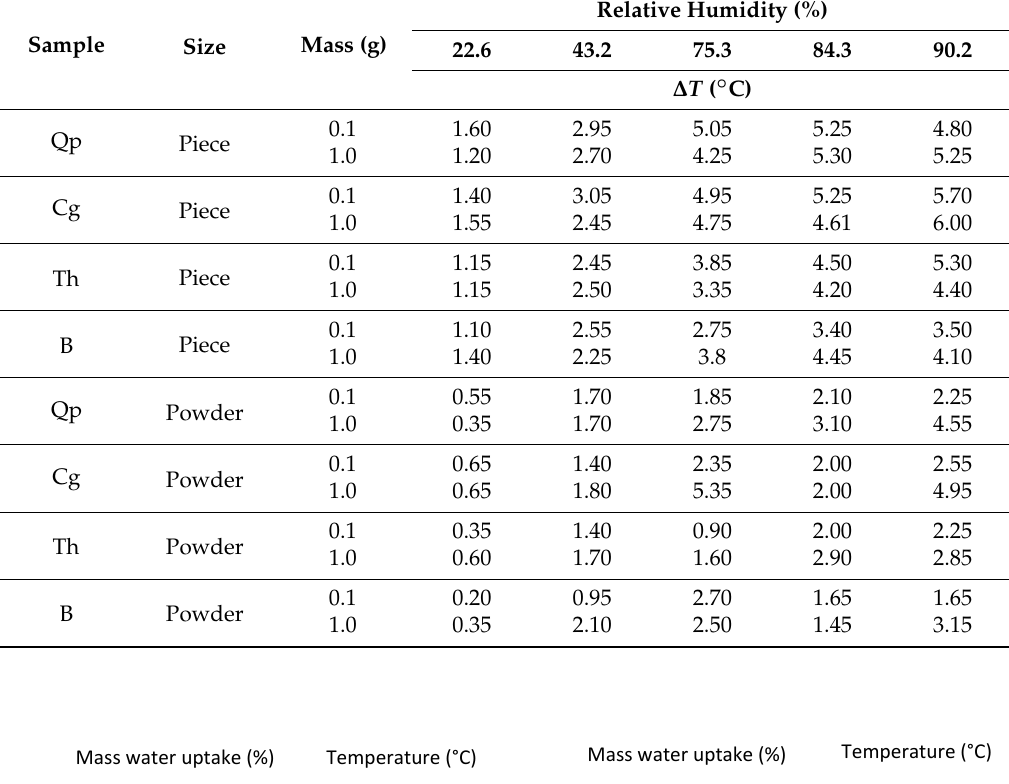
Table 4. Averaged values for temperature ( ◦ C) increasing from pieces and powdered biochars exposed